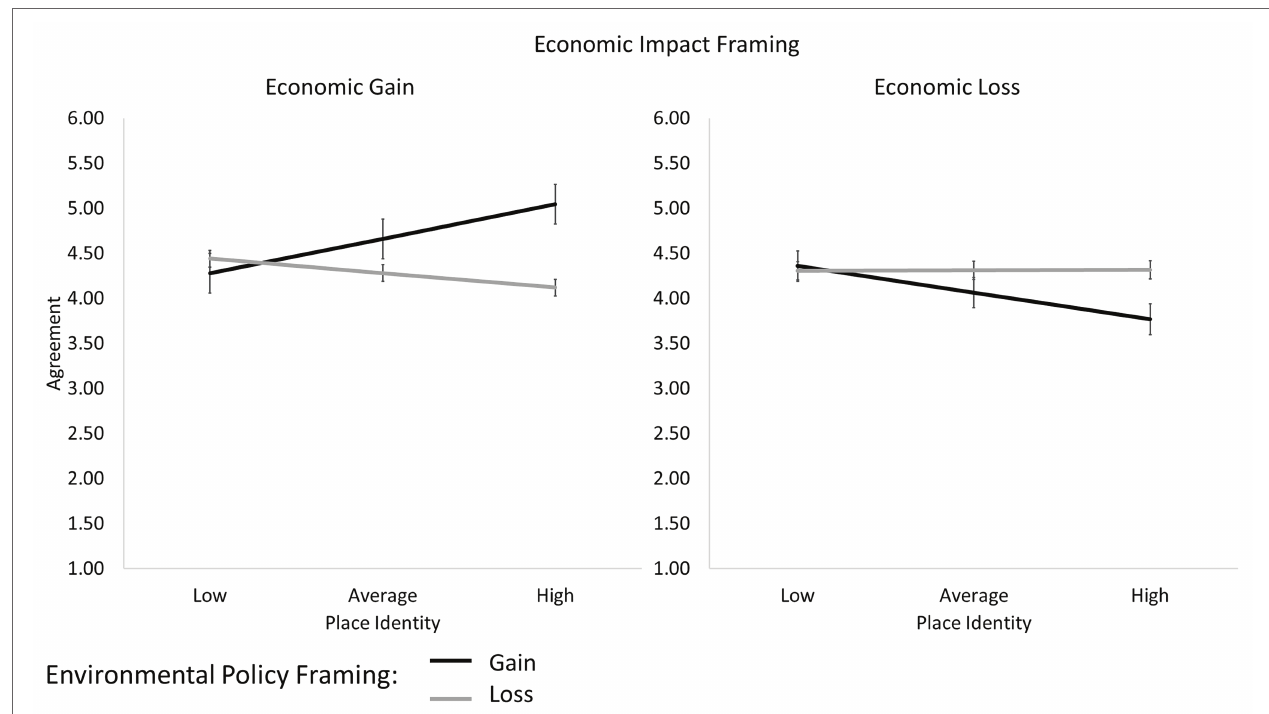
FIGURE 2 | Agreement with gain vs. loss messages on the economic impact of the policy as a function of gain vs. loss framing of the environmental policy and place identity (Study